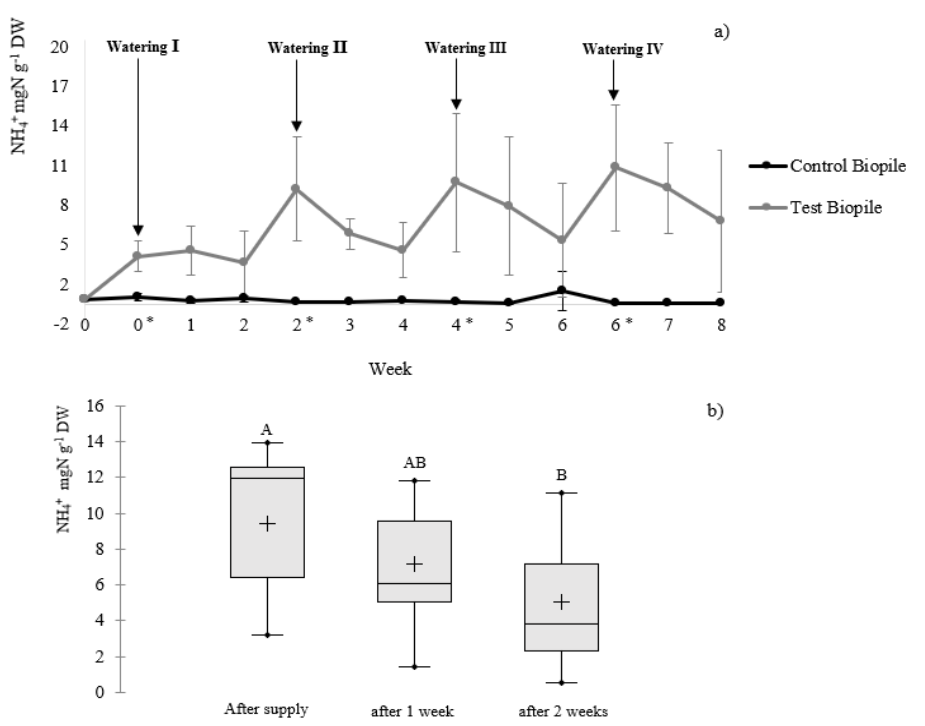
Figure 2. ( a ) Temporal evolution of the ammonium nitrogen (NH 4+ ) concentration in the water extracts, and ( b ) monitoring of the ammonium nitrogen (NH 4+ ) abatement evolution in the test biopile (* means after watering and the error bars represent standard deviations ( n = 3)). Different letters above boxplots indicate a significant difference between plots according to the Kruskal–Wallis test with Dunn’s procedure, p value = 0.05.